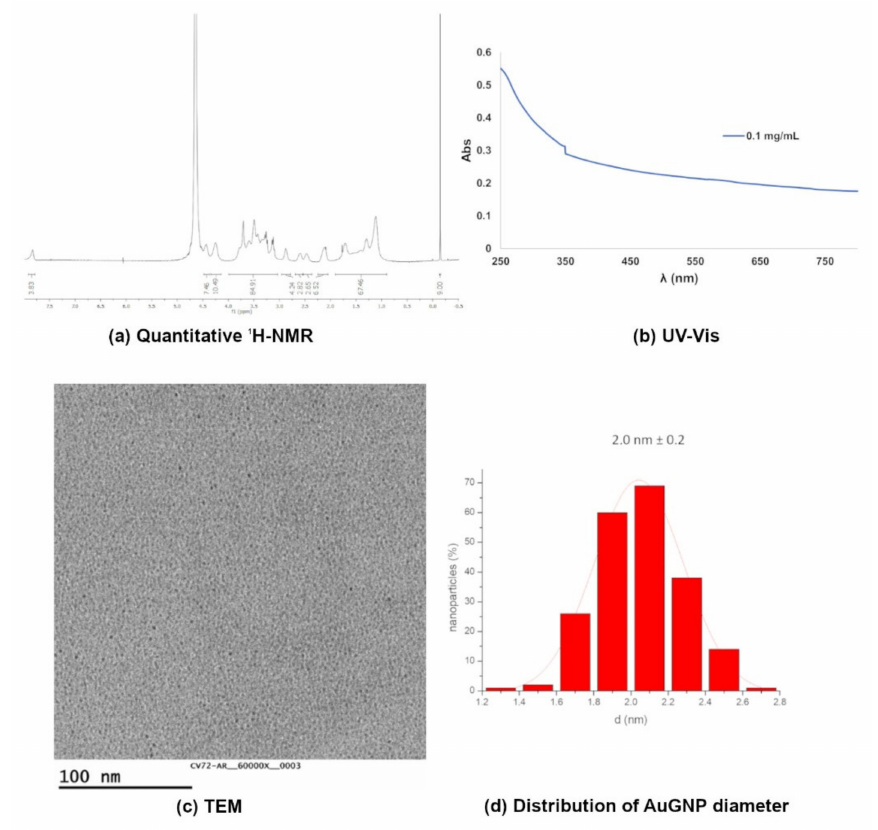
Figure 3. Characterization of AuGNP 3 (20% trisDNJ-Au- β Glc): ( a ) quantitative 1 H NMR (D 2 O) spectrum (400 MHz); ( b ) UV/Vis spectrum; ( c ) TEM micrograph in H 2 O; ( d ) size-distribution histogram, obtained by measuring 300 nanoparticles (average diameter 2.0 ± 0.2 nm).